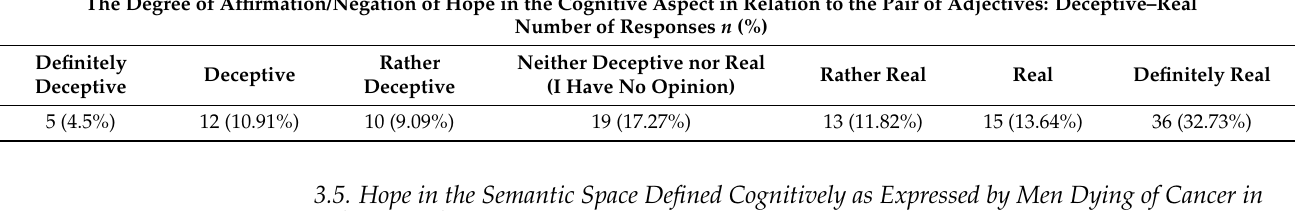
Table 7. The degree of affirmation/negation of hope in the cognitive aspect in relation to the pair of adjectives deceptive–real expressed by men in the terminal stage of cancer ( n =